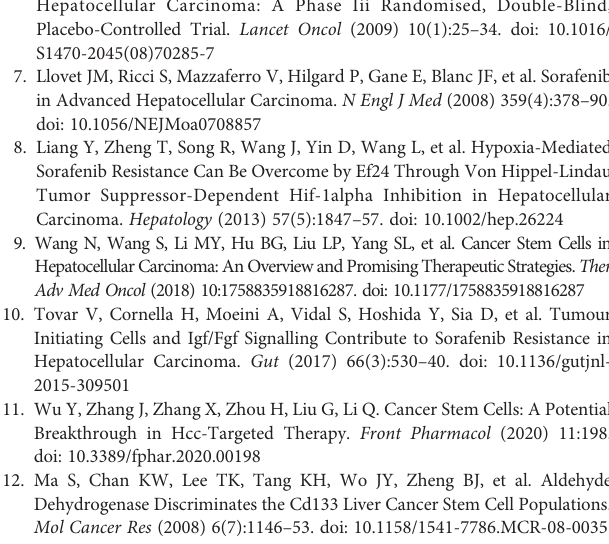
Supplementary Figure 1 | DSF/Cu downregulates the expression of stemness gene encode proteins and induces autophagic cell death via sustained activation of the ERK signaling pathway. The HCC cell lines HepG2, Hep3B, SNU387, and SNU423 were treated with DSF/Cu (0.4µM/1µM). Treated cells were lysed at different time points and analyzed by western blot for the expression of stemness genes encoded proteins, autophagy, apoptosis markers, and MEK/ERK pathway activation-related genes. The band density of each protein was quanti fi ed with ImageJ. The mean ± SD of each protein from 2 independent blots (while the protein expression level was relative to 0 h time point) are shown. * Indicates p<0.05, ** indicates p<0.01, *** indicates p<0.001, and **** indicates